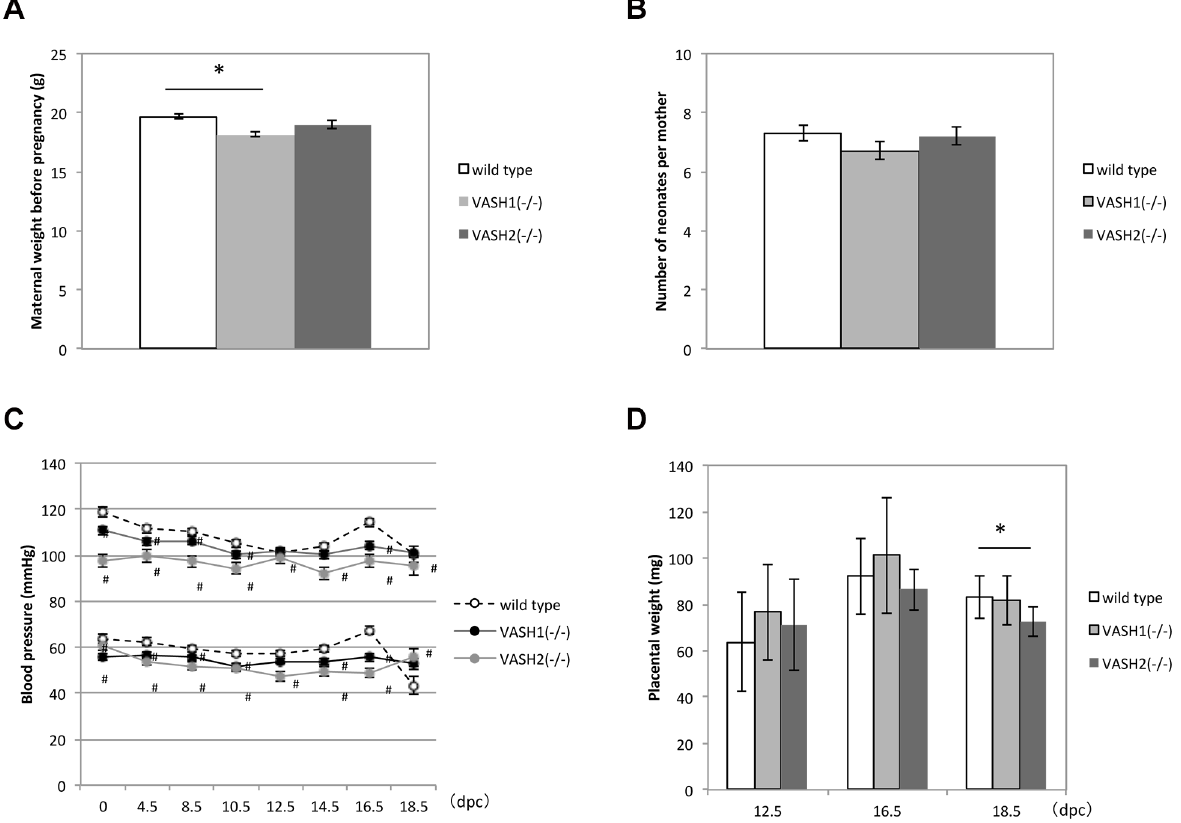
Figure 2. Course of pregnancy in WT, Vash1 ( 2 / 2 ) and Vash2 ( 2 / 2 ) mice. A: Comparison of maternal weights of WT (N=30), Vash1 ( 2 / 2 ) (N=45), and Vash2 ( 2 / 2 ) (N=20) mice. *P , 0.01. B: Comparison of number of neonates per WT (N=32), Vash1 ( 2 / 2 ) (N=45), and Vash2 ( 2 / 2 ) (N=20) dams. C: Blood pressure of WT (N=16), Vash1 ( 2 / 2 ) (N=15), and Vash2 ( 2 / 2 ) (N=7) dams measured at 0, 4.5, 8.5,10.5, 12.5, 14.5, 16.5, and 18.5 dpc. # P , 0.05. D: Wet weight of WT (N=37), Vash1 ( 2 / 2 ) (N=37), and Vash2 ( 2 / 2 ) (N=19) placentas. *P , 0.01.